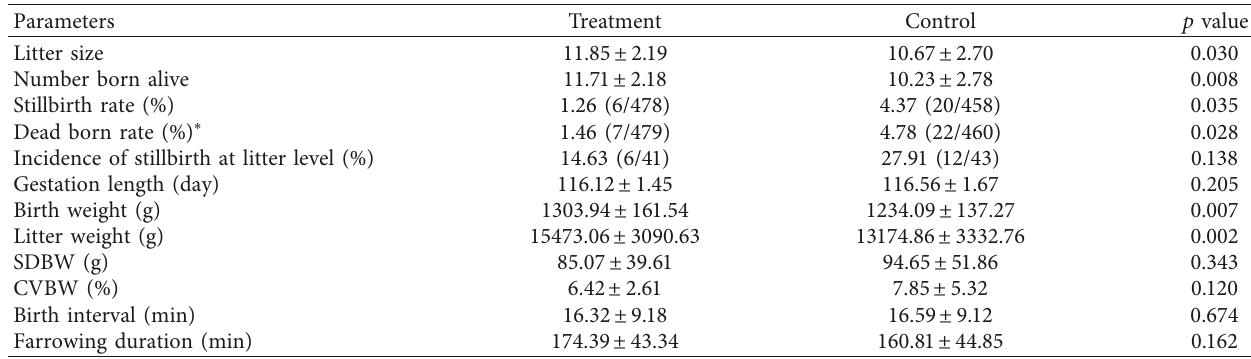
Table 2: Reproductive performance of the gilts at